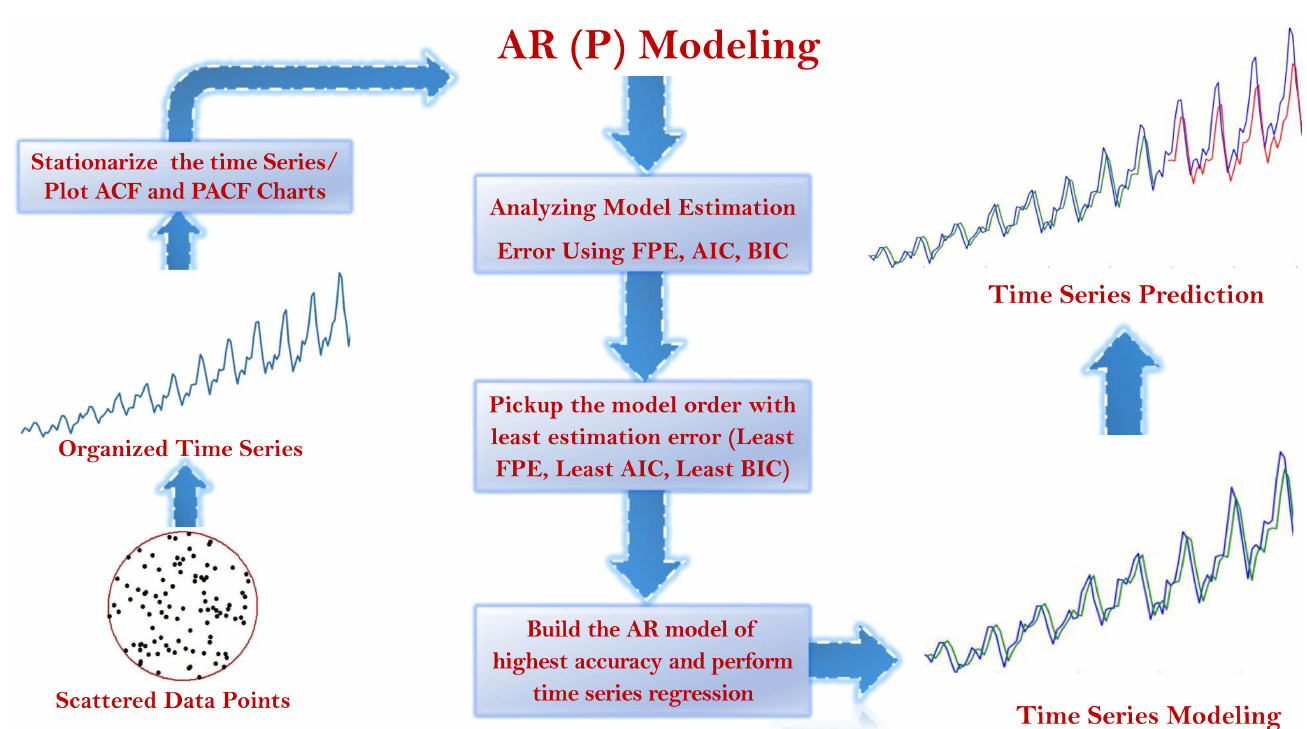
Figure 3. The structure chart for the time-series modeling approach illustrating the modeling procedure steps from scattered data points to the regularized predicted data points.